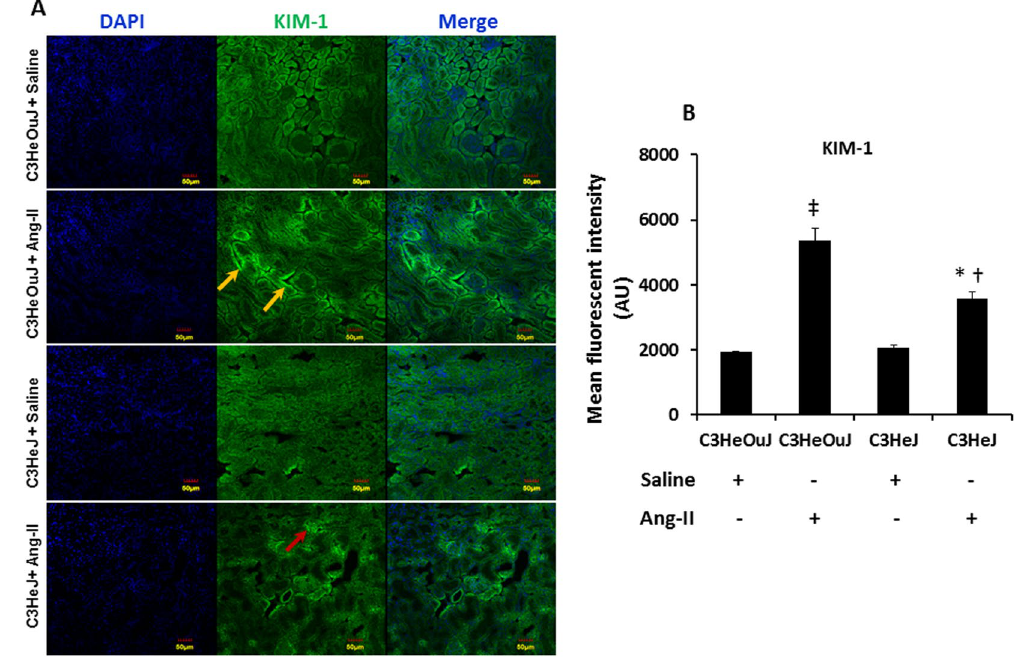
Figure 4. TLR4 deficiency protects the kidney from Ang-II mediated injury. ( A ) Representative images show Kidney injury molecule-1 immunofluorescence. Kidney sections from mice with normal TLR4 show increased KIM-1 fluorescence to Ang-II treatment in tubular areas (yellow arrows) compared to TLR4 deficiency mice (red arrow). ( B ) Data shows mean fluorescent intensity ± SEM. n = 5/group, tested by Kruskal-Wallis test. Scale bar - 50 µ m. Magnification × 20. * p < 0.05 vs. C3HeJ + saline, † p < 0.05 vs. C3HeOuJ + Ang-II, ‡ p < 0.05 vs. C3HeOuJ + saline. C3HeOuJ: normal TLR4, C3HeJ: TLR4